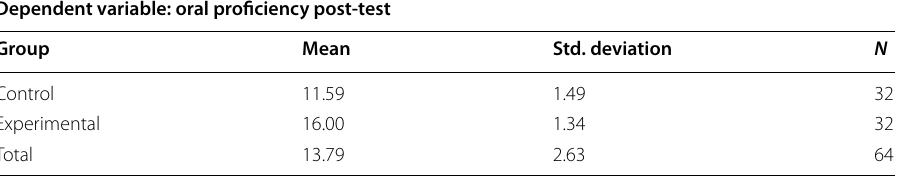
Table 9 Oral proficiency descriptive statistics